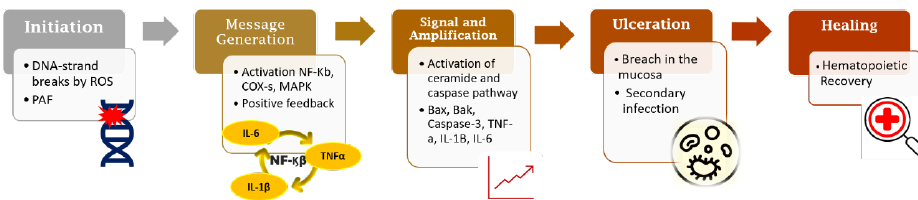
Figure 1. Five-phase pathobiological model of oral mucositis. Based on this model, the process trigger is DNA damage induced by radio-chemotherapy followed by activation of inflammatory pathways together with apoptosis. These processes lead to the loss of integrity of the mucosal barrier and subsequent wound formation. The end of the signalling pathway occurs spontaneously after cessation of tissue damage.